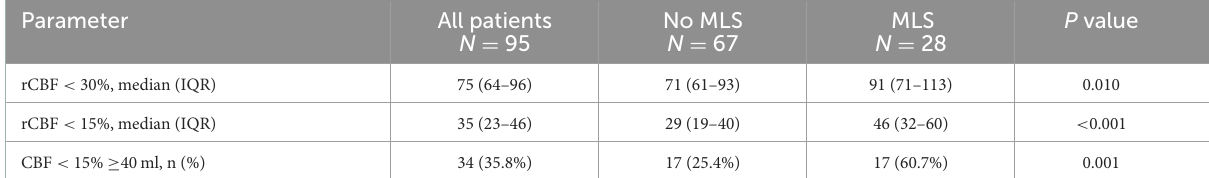
TABLE 2 Comparison of baseline infarct core between patients with early severe MLS presence and without early severe MLS presence. Parameter All patients N = 95